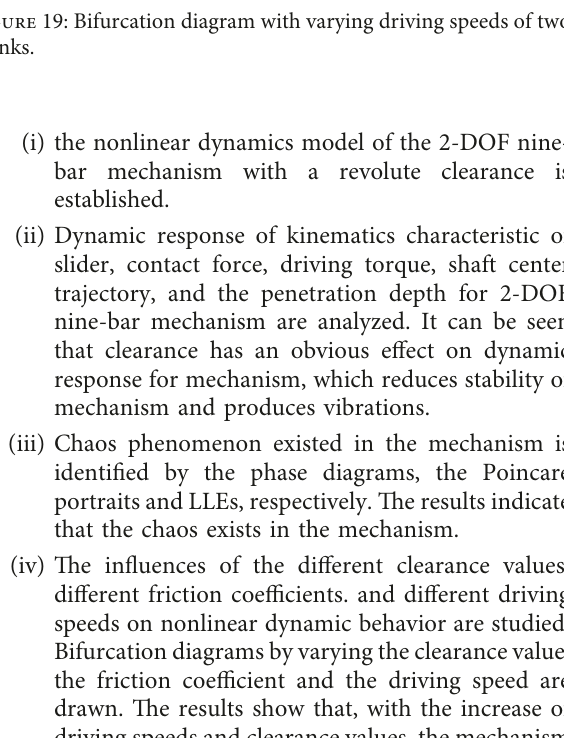
Figure 19: Bifurcation diagram with varying driving speeds of two cranks.